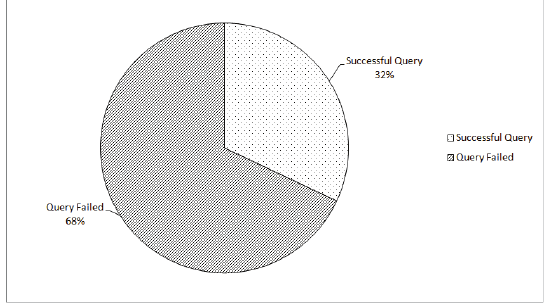
Fig. 8. Query successful vs. unsuccessful - Flooding